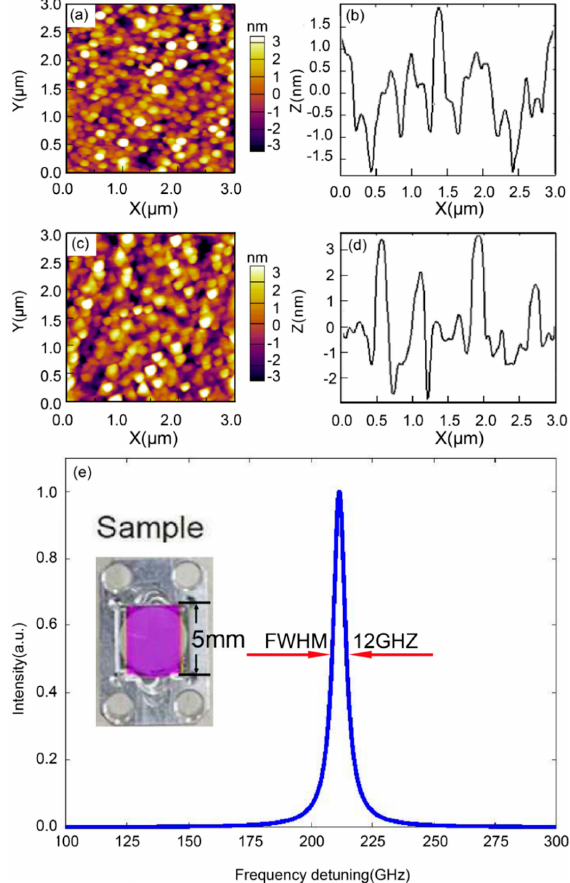
Figure 1. ( a ) Surface morphology of the front and ( c ) rear surface of the sample. ( b ), d ) Surface roughness Figure 1. (a) Surface morphology of the front and (c) rear surface of the sample. (b) and (d) Surface scanned at center position of ( a ), and ( c ) respectively. ( e ) Measurement of the Fabry-Perot microcavities roughness scanned at center position of (a), and (c) respectively. (e) Measurement of the Fabry-Perot (FPMC) cavity linewidth. Full-width half-maxima (FWHM), full-width half-maxima. Inset: Image of the used FPMC